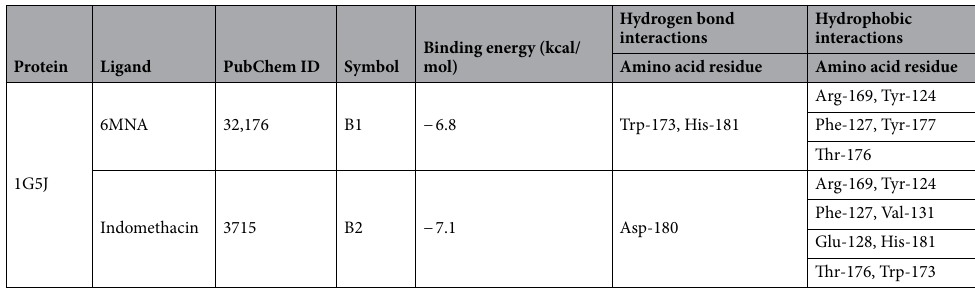
Table 5. Binding energy and interactions of potential two NSAIDs on BAD (PDB ID: 1G5J).